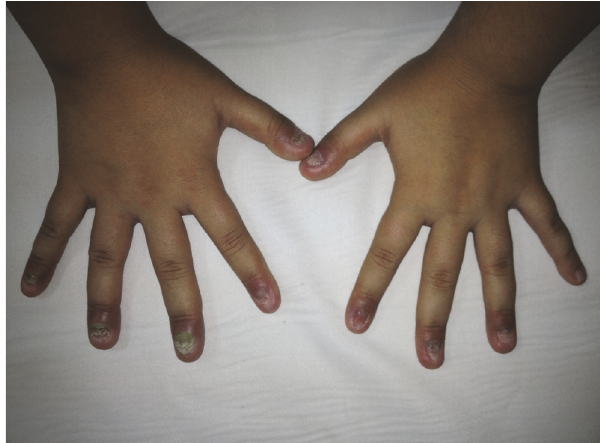
Figure 1: Dystrophic nails of the hand with nail psoriasis (leukony- chia, nail plate crumbling, and onycholysis) accompanied by ony- chomycosis at